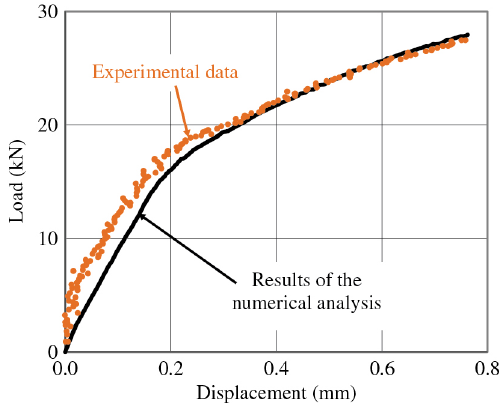
Figure 6: Validation of the model against experimental results.